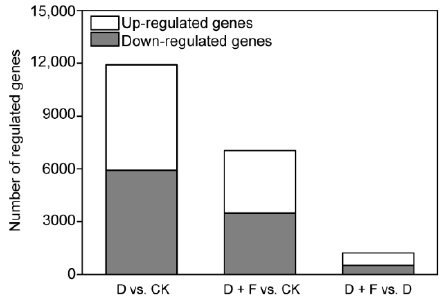
Figure 2. Summary of the numbers of differentially expressed genes (DEGs) in leaves of B. napus with drought and fullerol treatments. CK: check (sufficient water condition); D: drought; F: fullerol.